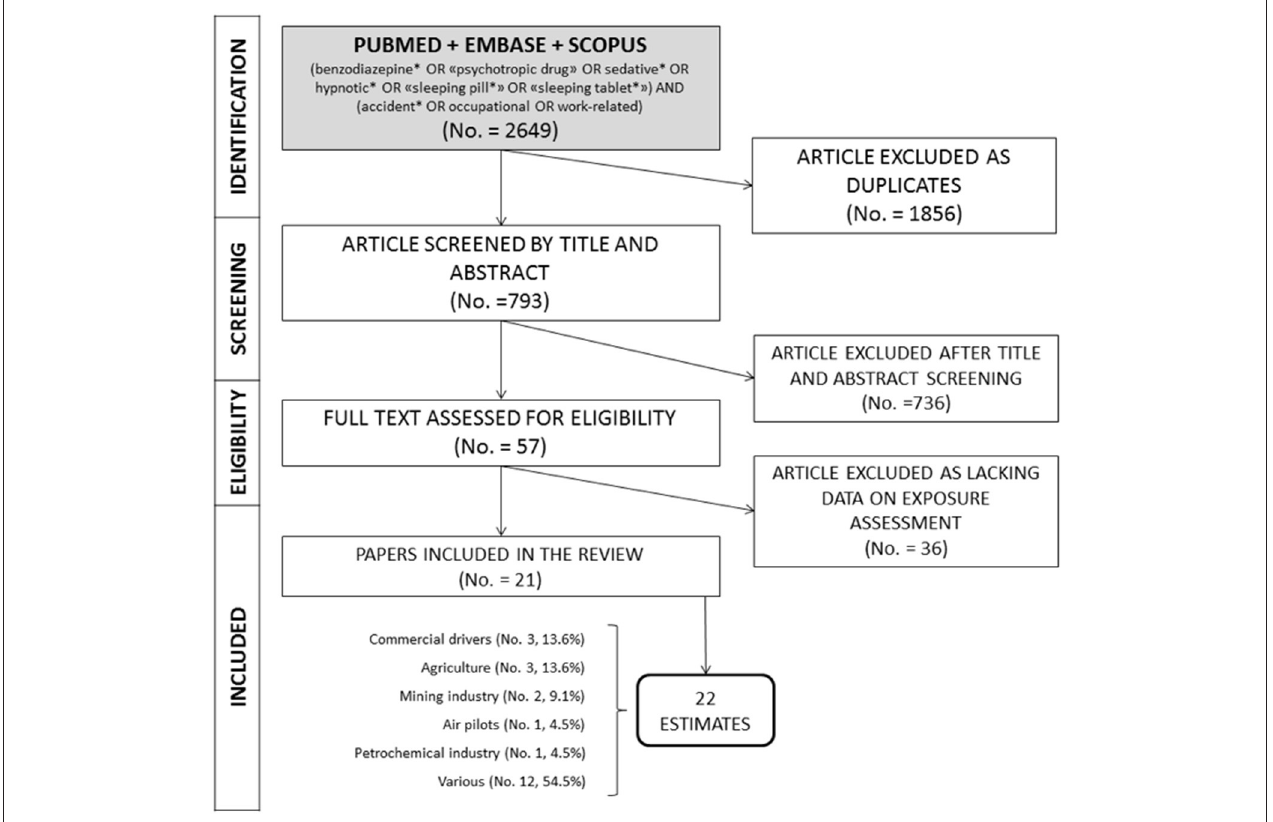
FIGURE 1 | Preferred Reporting Items for Systematic reviews and Meta-Analysis (PRISMA) flow diagram for inclusion of studies in the meta-analysis.